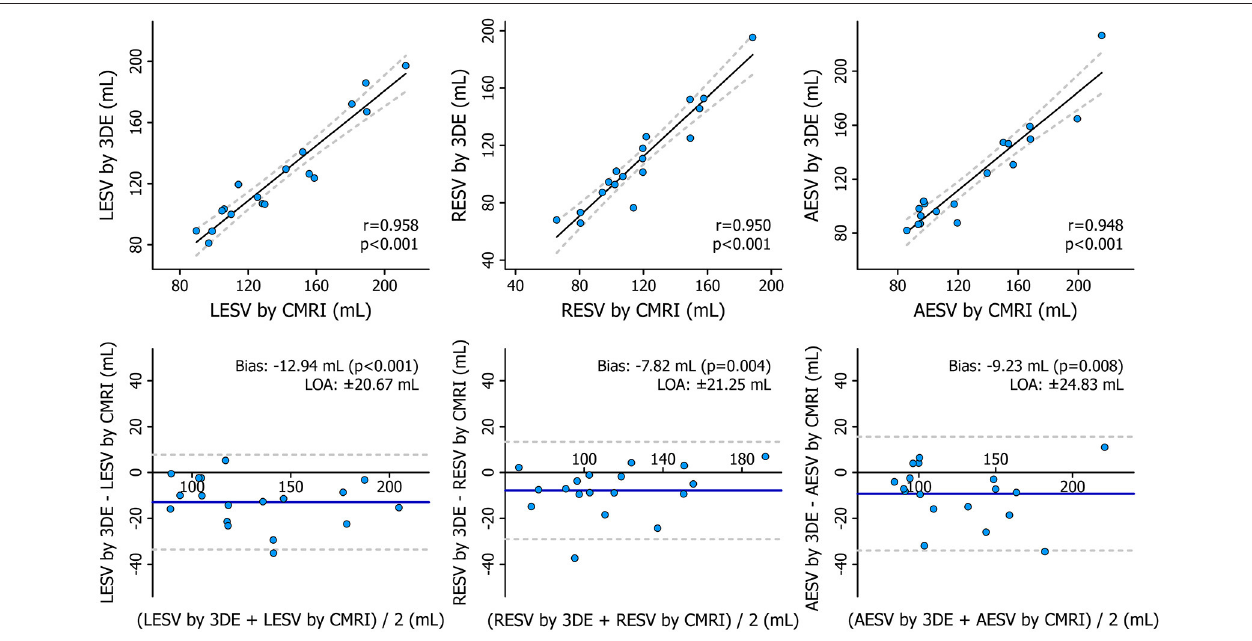
FIGURE 9 | Correlation and agreement between 3D echocardiography- and cardiac magnetic resonance imaging-derived measurements of right ventricular decomposed end-systolic volumes depicted by correlation and Bland–Altman plots. Statistical tests: same as in Figure 8 . 3DE, 3D echocardiography; AESV, anteroposterior end-systolic volume; CMRI, cardiac magnetic resonance imaging; LESV, longitudinal end-systolic volume; LOA, limits of agreement; RESV, radial end-systolic volume.